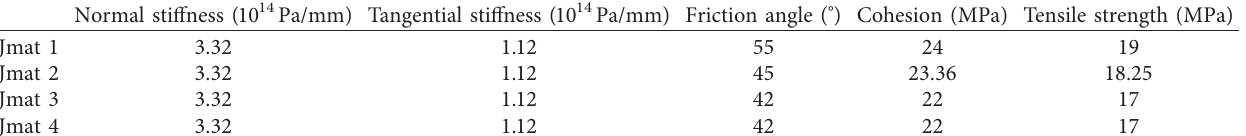
Table 2: Contact parameters.